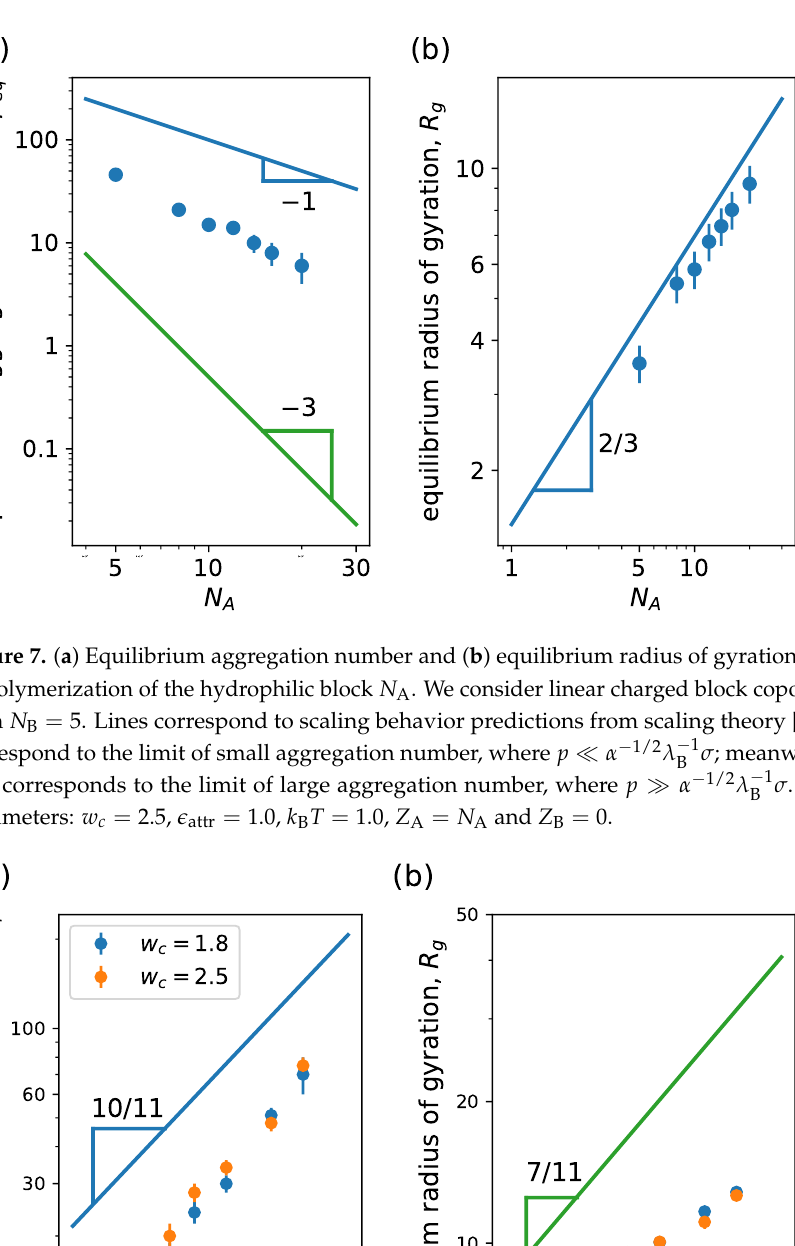
w c . Notice the theoretical exponents coincide with that of linear block copolymers (Figure 6), and our simulations resemble the scaling behavior of the linear case too.